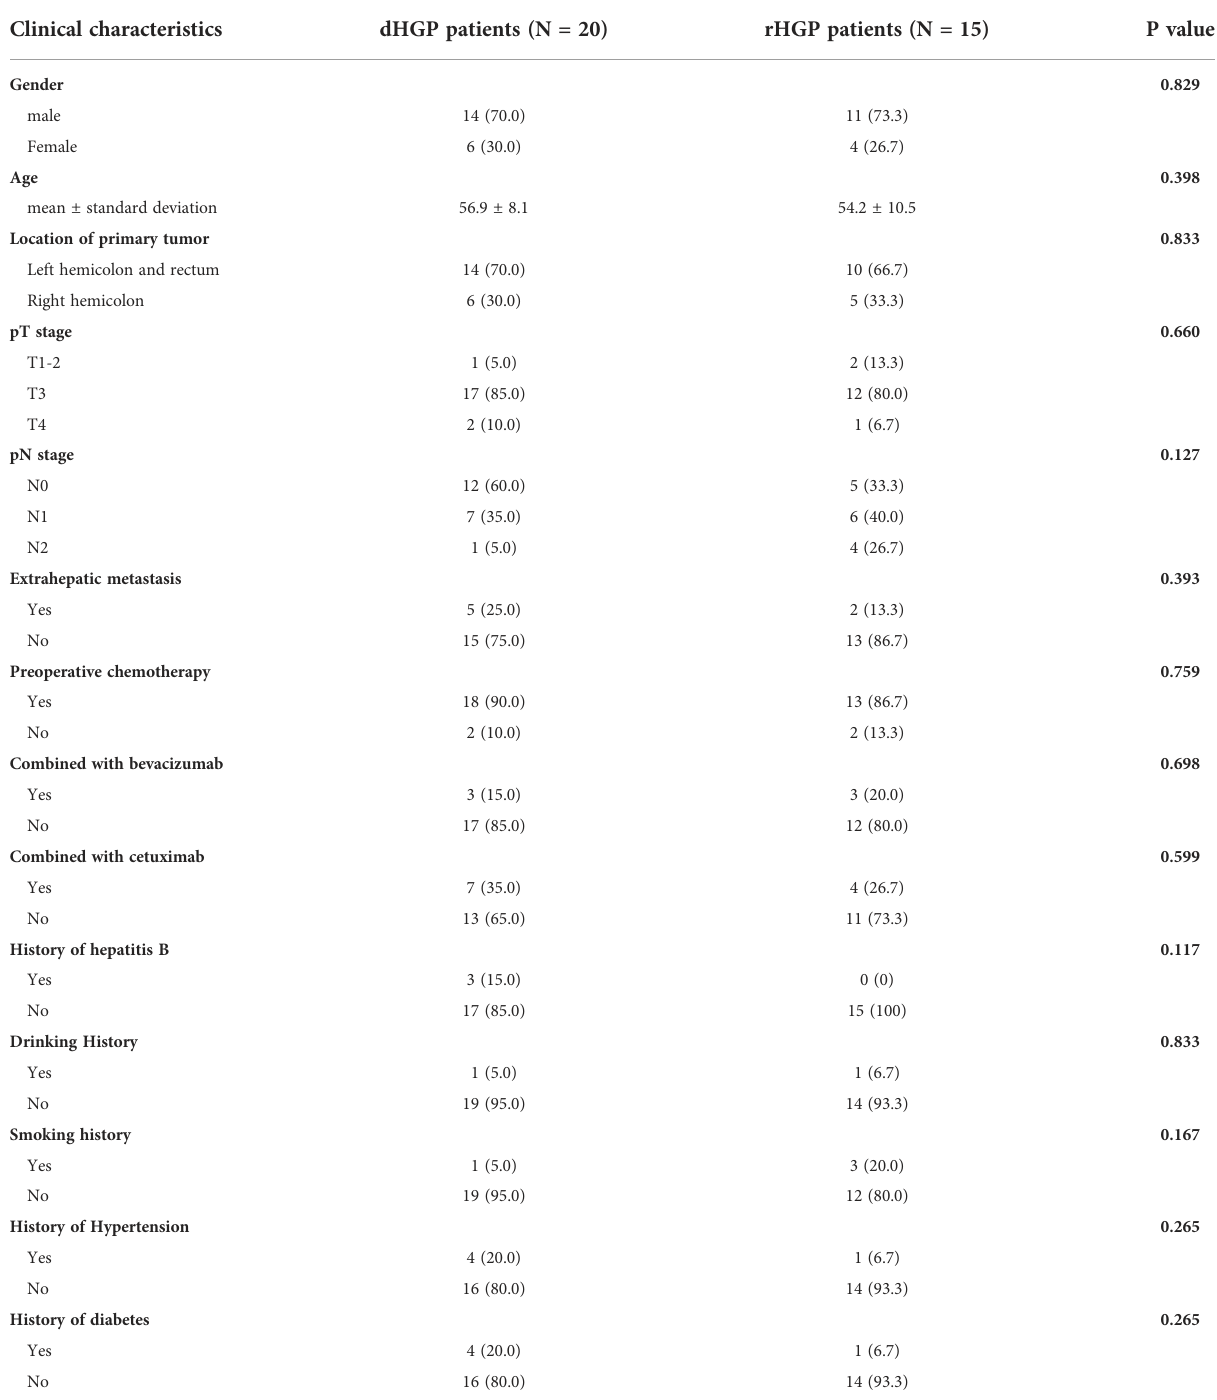
TABLE 1 Clinical characteristics of dHGP and rHGP patients. Clinical